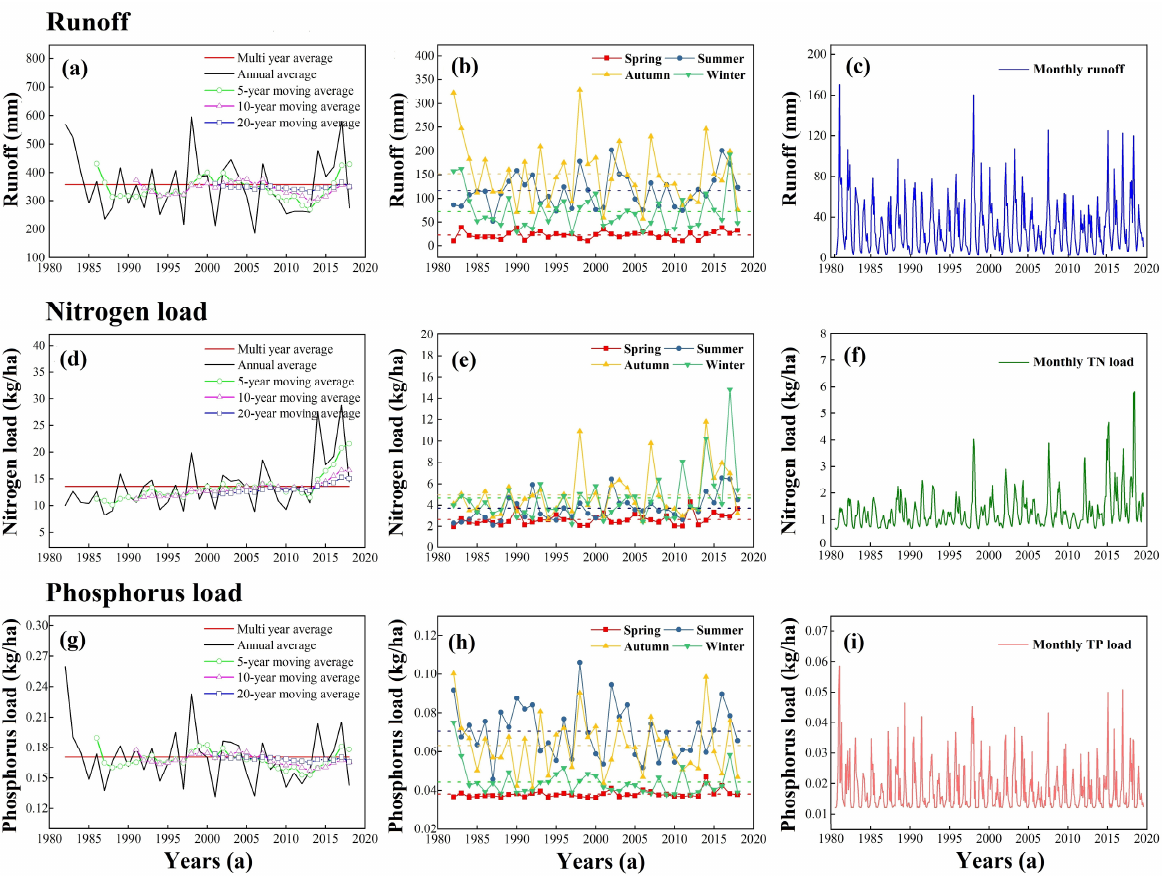
Figure 7. The moving average value, annual, season, and month variation trend of runoff ( a – c ); TN ( d – f ); and TP ( g – i ) loads.